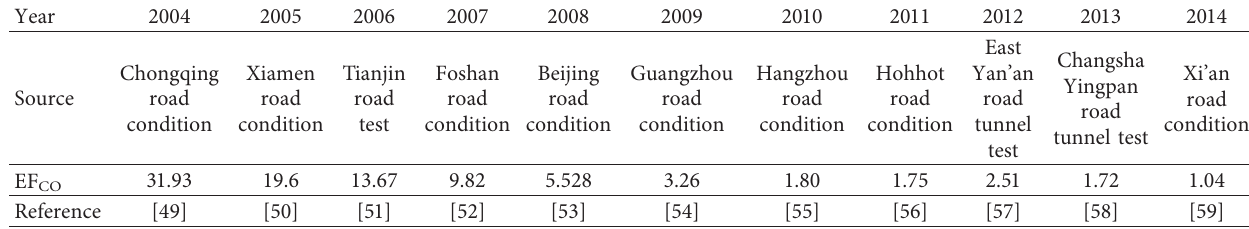
Table 2: The CO emission factors of passenger cars (g/(km · veh)).